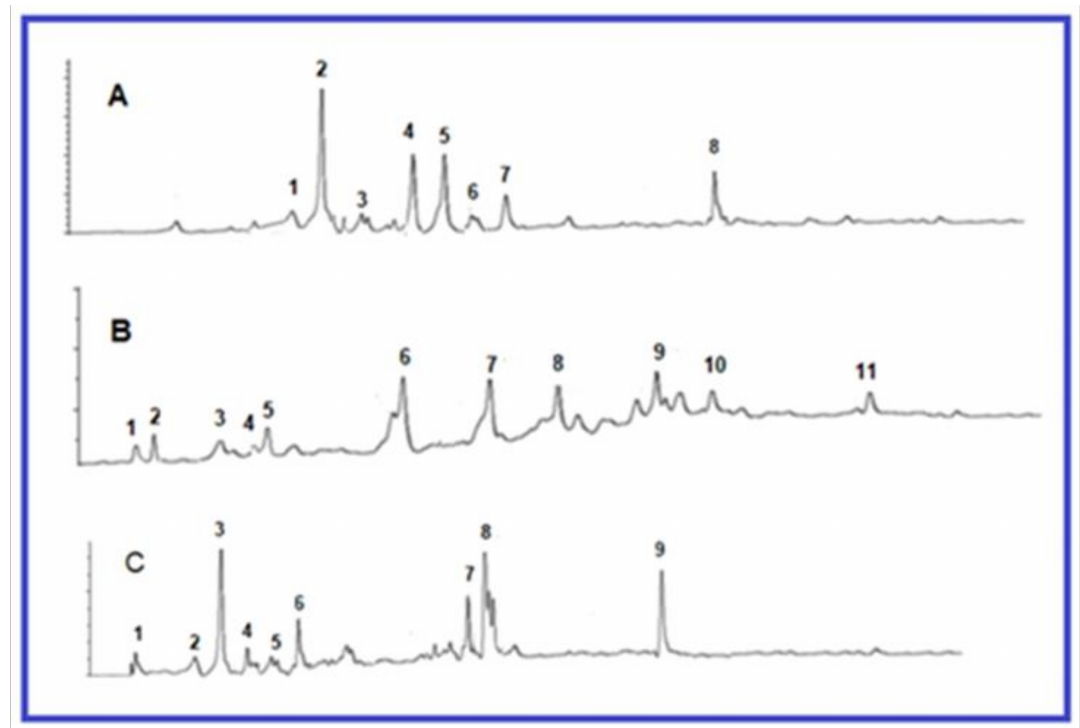
Figure 1. HPLC chromatogram of ( A ) U. dioica : isorhamnetin-3- O -rutinoside (1); quercetin-3-o-glucoside (2); kaempferol-3- O -glucoside or astragalin (3); myrecetin (4); naringin (5); rutin (6); ferulic acid (7); ellagic acid (8); ( B ) Z. officinale: morin (1); gallic acid (2); fisetin (3); vanillic acid (4); epicatechin (5); trans -cinnamic acid (6); kaempferol (7); naringenin (8); rutin (9); ferulic acid (10); quercetin (11); ( C ) A. graveolens chlorogenic acid (1); vanillic acid (2); caffeic acid (3); syringic acid (4); luteolin (5); p -coumaric acid (6); rutin (7); ferulic acid (8); quercetin